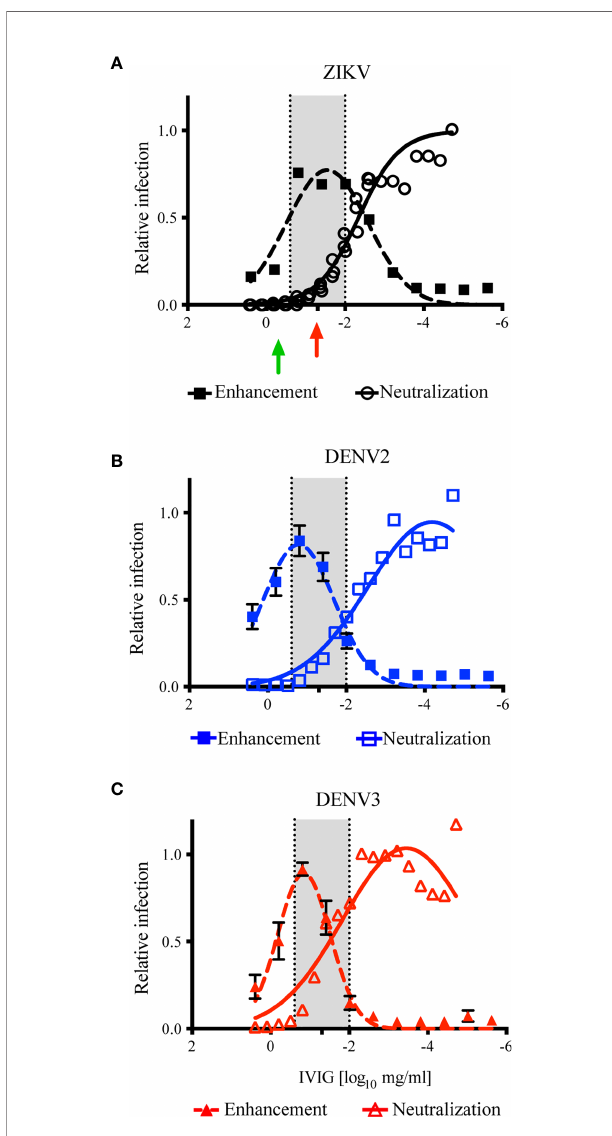
FIGURE 3 | Calculation of ZIKV-IG disease enhancement dose. The overlay of the results of ZIKV-IG antibody neutralization in Vero cells (open symbols) and antibody enhancement in K562 cells (closed symbols) for ZIKV, DENV2 and DENV3. The in vitro neutralization data from Figure 1 was normalized to 1 = 100% infection. The in vitro ADE data in Figure 2 was normalized to the peak of infection for each respective virus, with 9.59 fold enhancement for ZIKV at a peak at 0.03 mg/ml, 13.58 fold enhancement for DENV2 at 0.159mg/ml, and 17.47 fold enhancement for DENV3 at 0.156mg/ml. The ADE data was then fi t using a gaussian dose response function, to identify the peak of ADE activity and to de fi ne where the ADE concentration crossed antibody neutralization. A region where antibody neutralization begins to decrease and antibody enhancement increases is highlighted in grey, to outline the potential dose curve where subjects could be at risk (249mg/ml to 0.01mg/ml). (A) The antibody neutralization and ADE of ZIKV by the ZIKV-IG is presented. The green arrow is the concentration of antibody that has been shown by Bardina et al. to protect against ZIKV disease and the red arrow represents the dose chosen to evaluate for the potential enhancement of disease in vivo . (B) The antibody neutralization and ADE of DENV2 by the ZIKV-IG is shown. (C) The antibody neutralization and ADE of DENV3 by the ZIKV-IG is